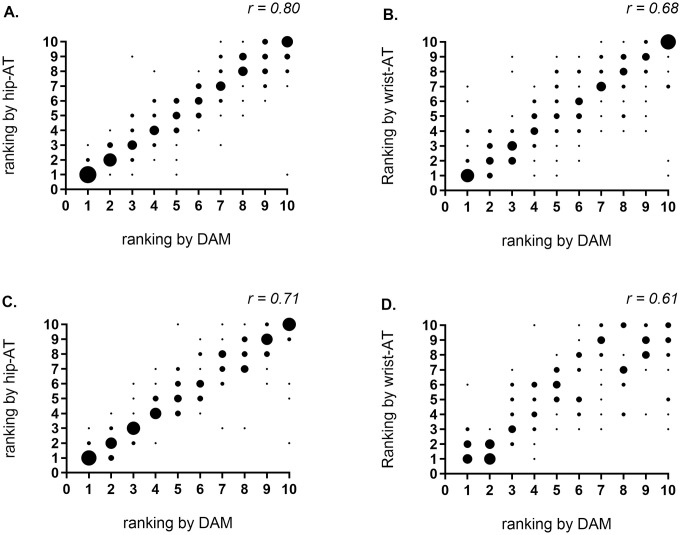
Ranking of daily step count by DAM compared to ranking by activity trackers.DAM compared to hip-AT in COPD (panel A) and healthy controls (panel C) and compared to ranking by wrist-AT, in COPD (panel B) and healthy controls (panel D). The larger the dot, the larger number of subjects for the given combination of ranks, r = Kendall correlation for consistency of ranking. Hip-AT = Fitbit Zip; wrist-AT = Fitbit Alta; DAM = Dynaport Movemonitor.